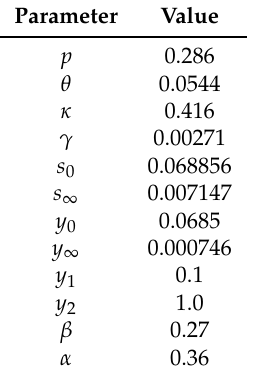
Table 1. PTW parameter set 1.